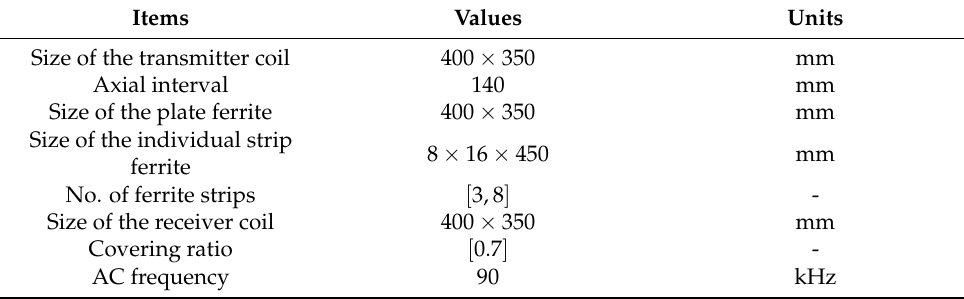
Table 4. Parameter settings for ferrite structure simulation.